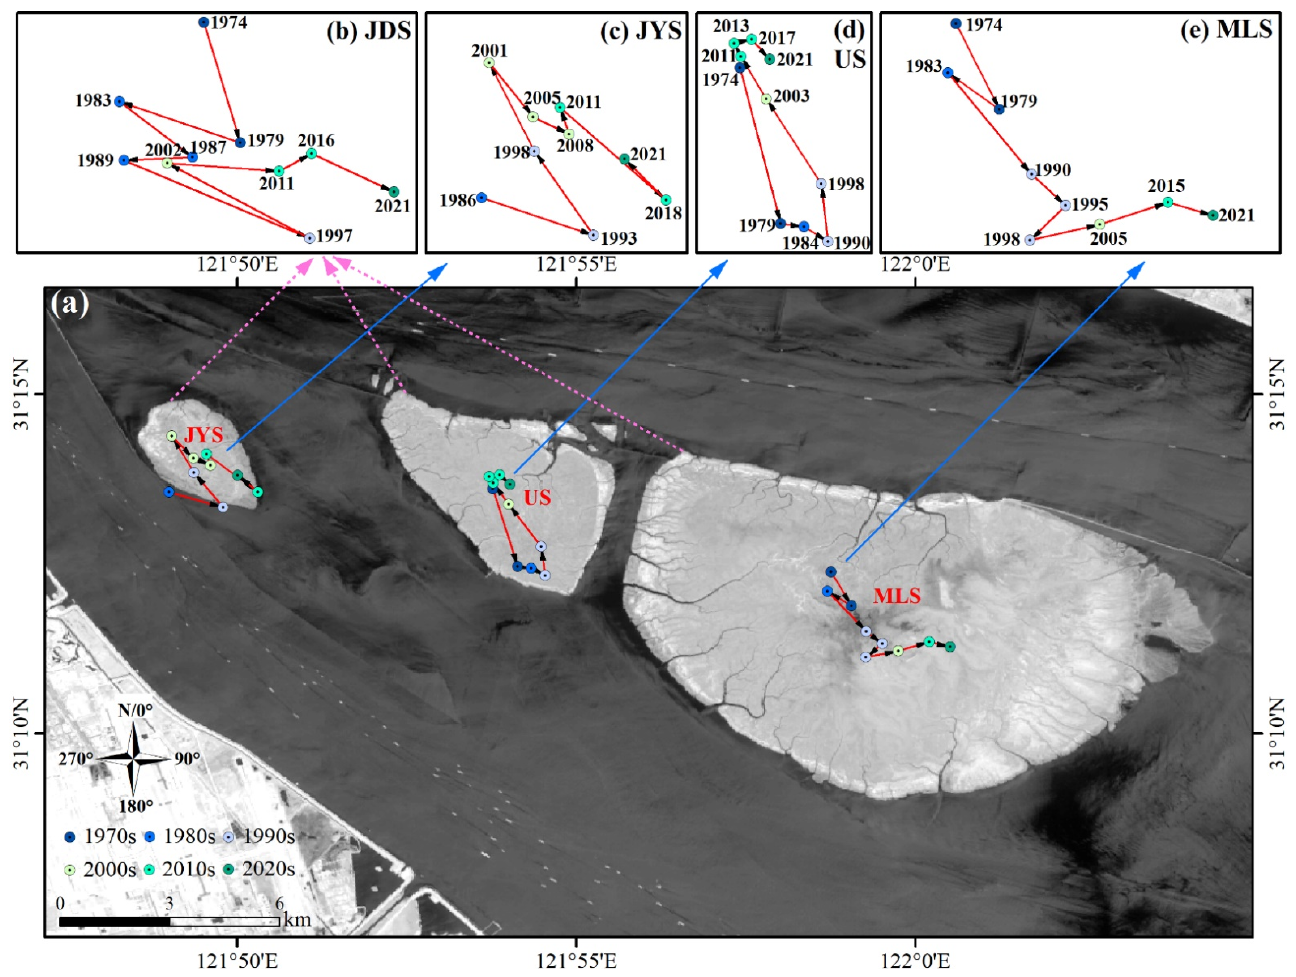
Figure 6. Centroid changes of the annual probability waterlines in each shoal ( a ), in the JDS ( b ). Zoom-in views for the JYS ( c ), the US ( d ) and the MLS ( e ). Table 1. Variation in the centroid orientation and speed of annual instantaneous